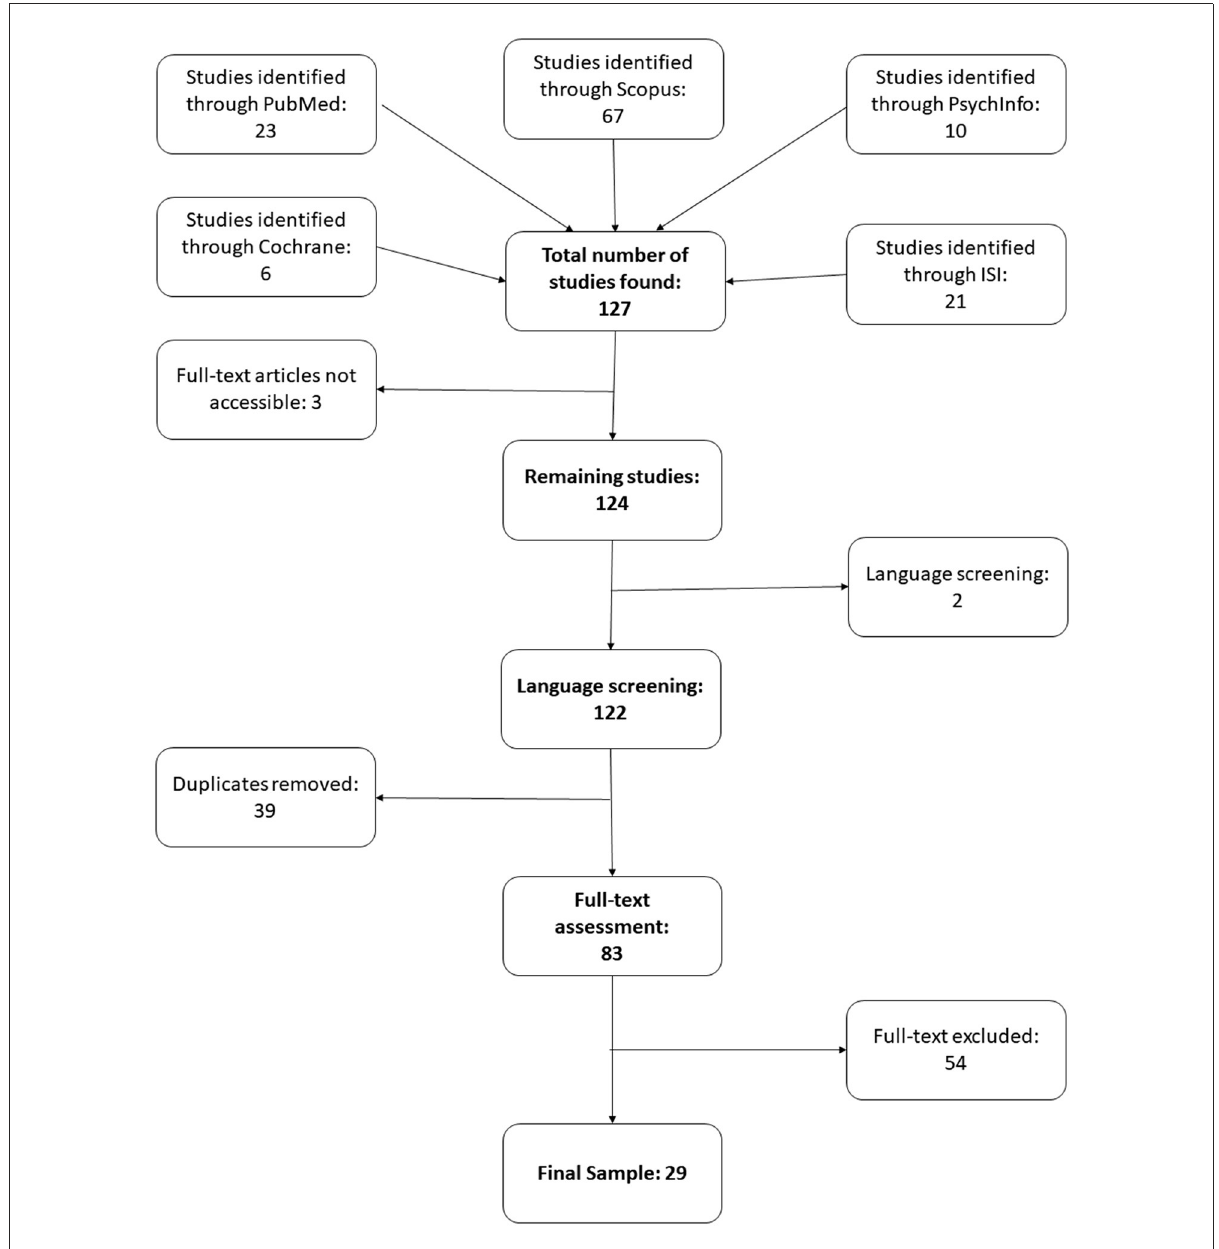
FIGURE1 Flow chart of the search and selection stages of the